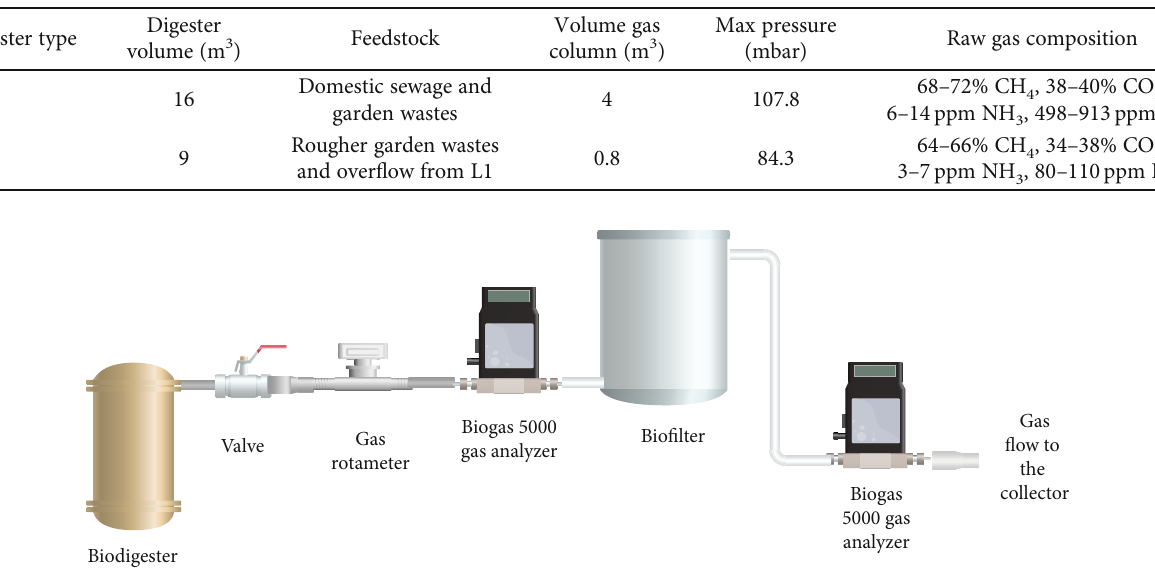
Table 2: Domestic biodigesters used for the analysis.